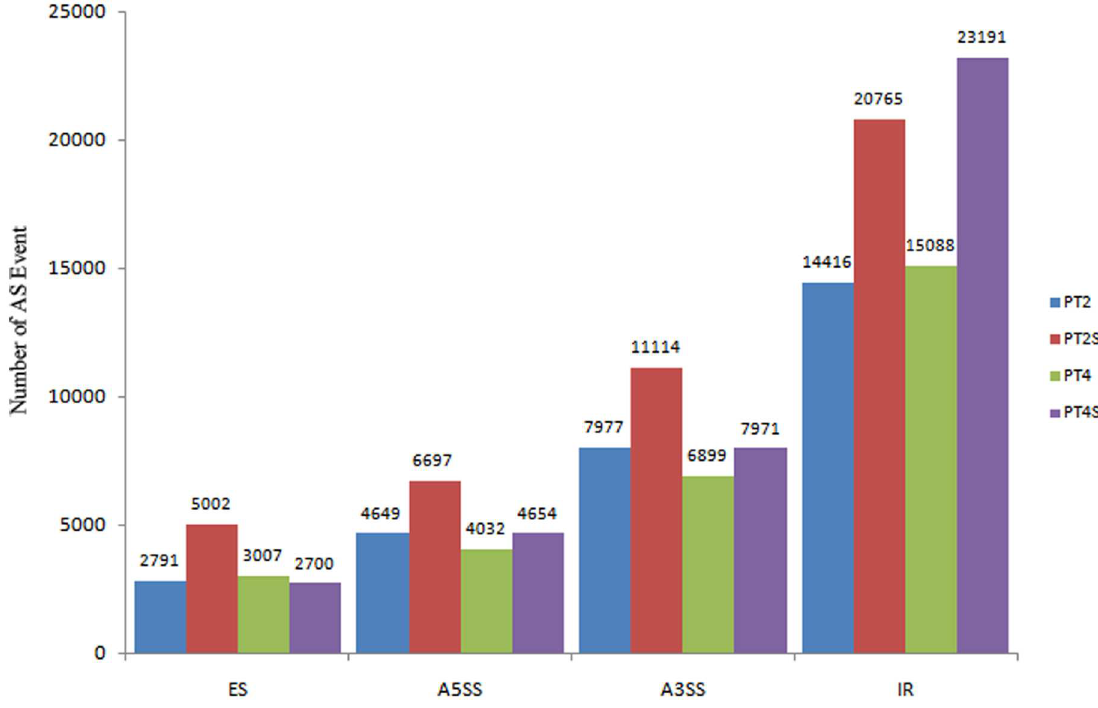
Fig 7. Classification of the four main AS events in this